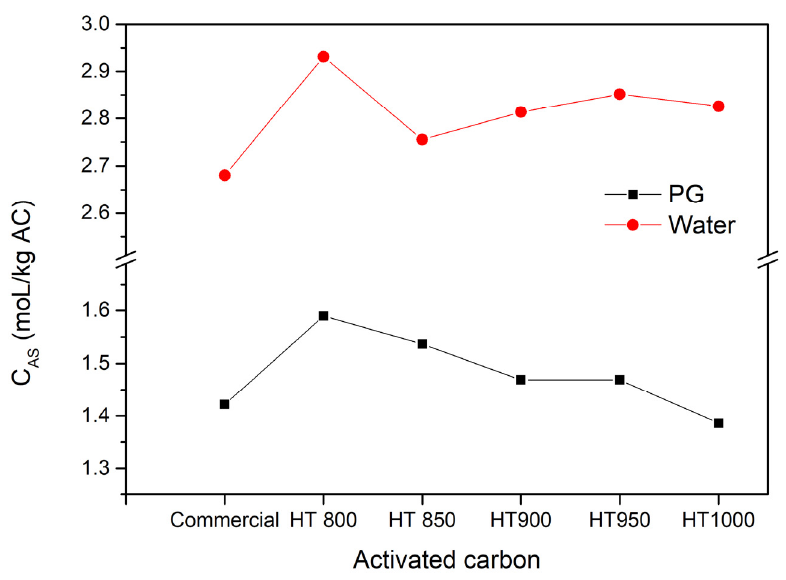
Figure 5. 1,2-propanediol and water adsorption onto heat treated activated carbon.